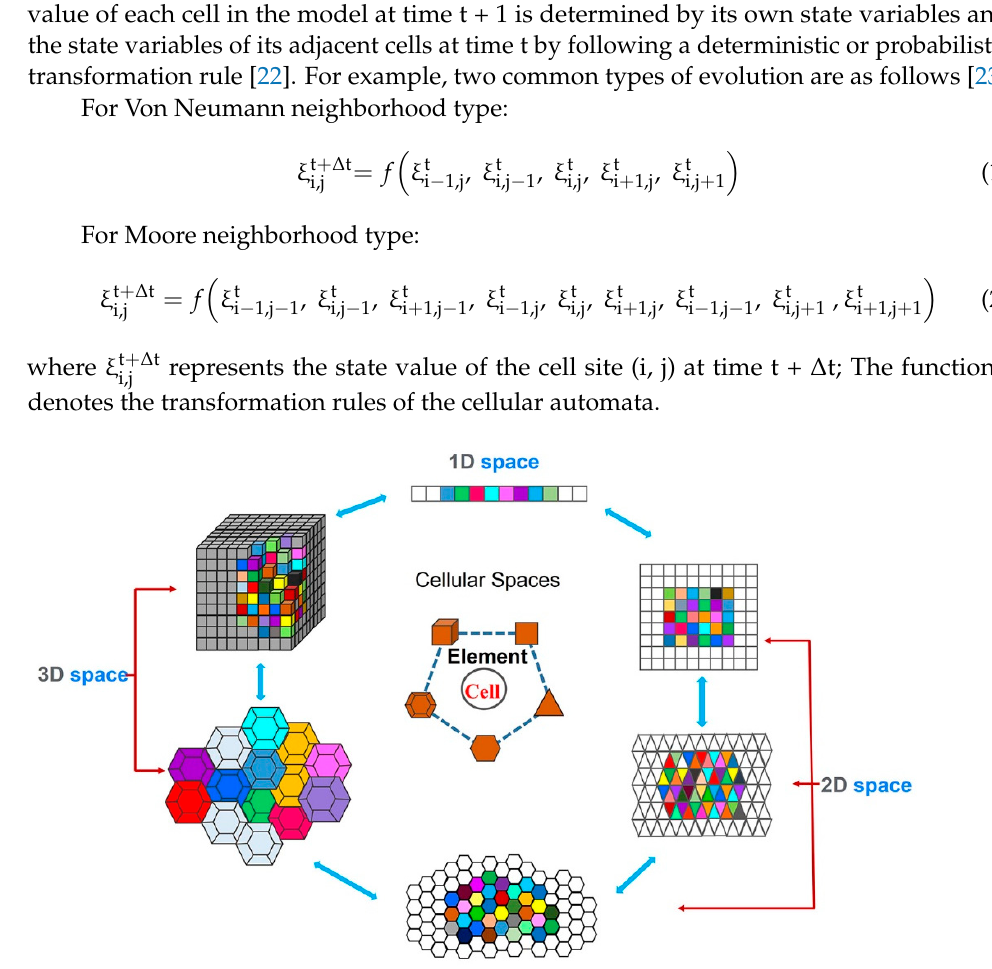
Figure 3. The elements of the cell and the spatial dimensions of the simulation.